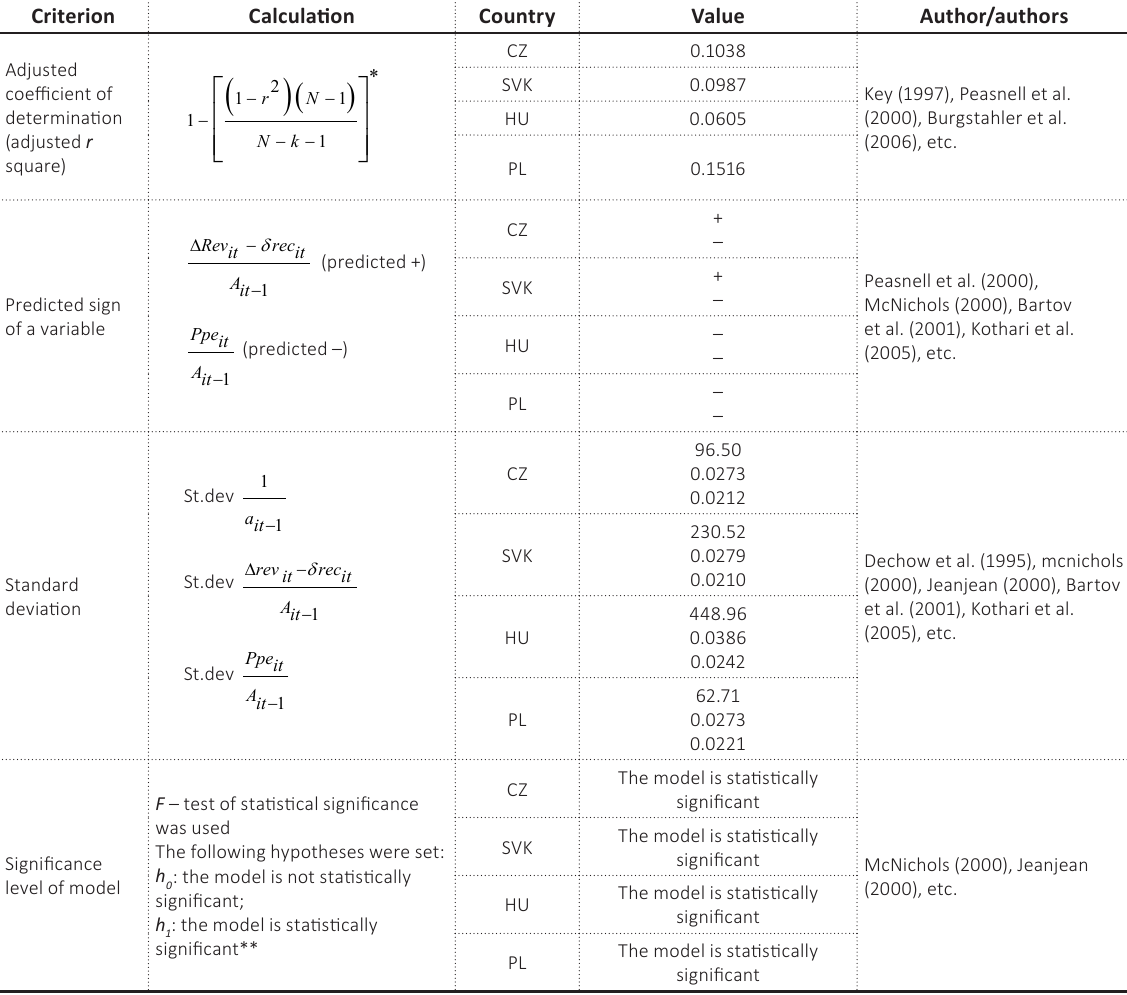
Table 5. Explanatory power of the model used within countries